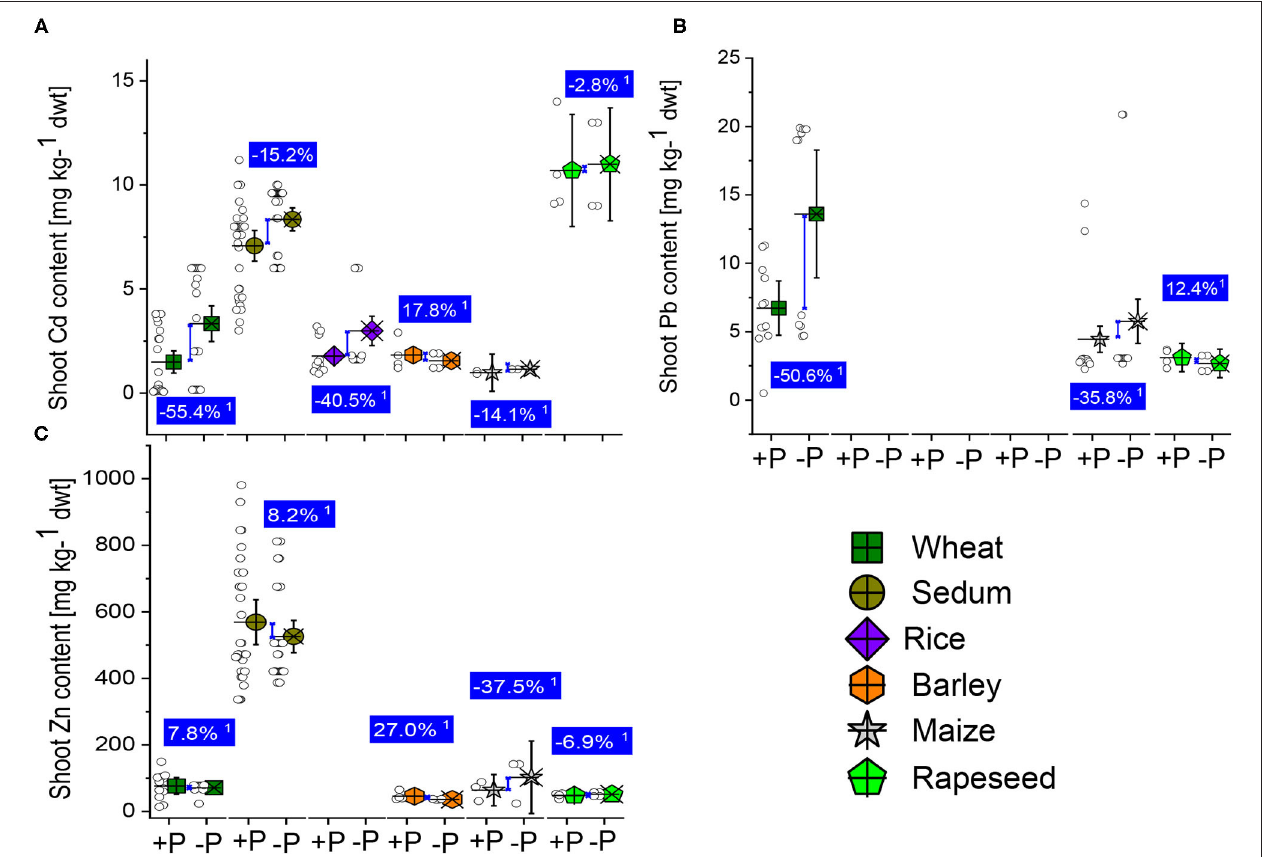
FIGURE 6 | Boxplots and scatter data of shoot Pb (A) Cd (B) and Zn (C) contents under + P and –P conditions of wheat, sedum, rice, barley, maize, and rapeseed plants. 1 Average change (%) of the + P applied over P-deficient plants. Means + bootstrap at 95% CIs of two tested P treatments that do not overlap zero indicate a significant relative increase